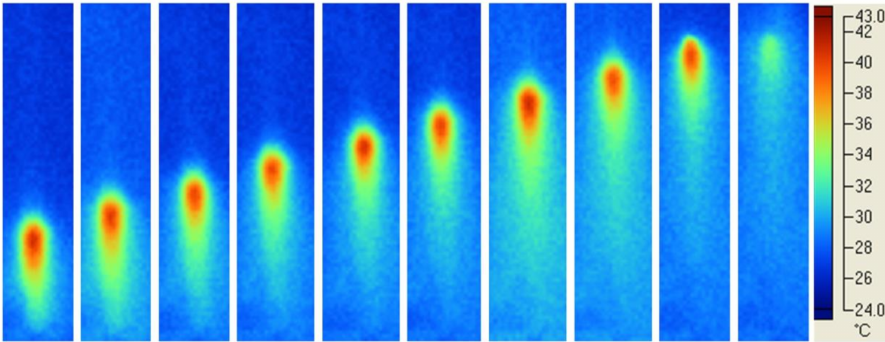
Figure 4. Light curing of EPH composite: typical temperature profiles using Mode I and laser beam. The dot-shaped beam light along the whole length of the specimen was observed. Photograms were taken every 4 s.